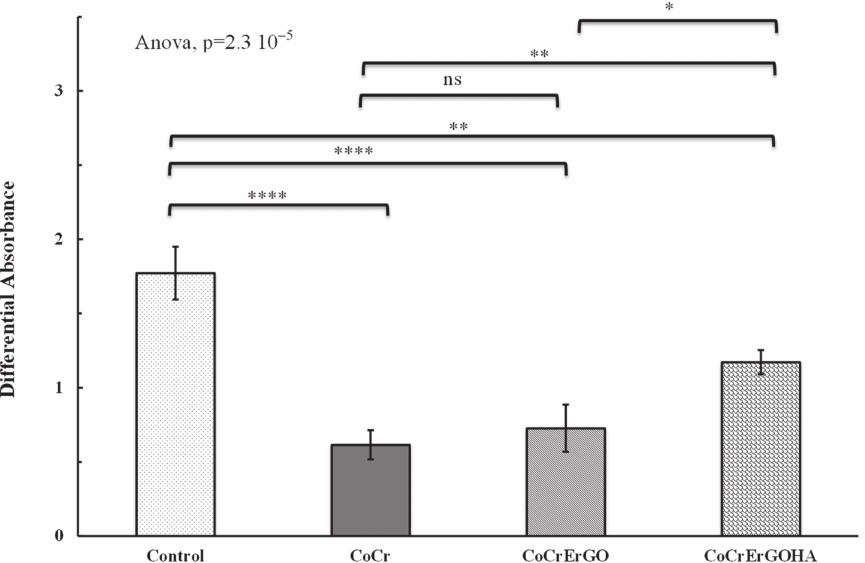
Figure 5. Effect of CoCr, CoCrErGO, and CoCrErGOHA surfaces on the proliferation and viability of macrophages’ J774A.1 cultures. Macrophages were also cultured in the absence of any discs, used as a control. Differences were significant at p value ≤ 0.05 (*: p ≤ 0.05, **: p ≤ 0.01 and ****: p ≤ 0.0001) and values with p > 0.05 were considered non significant